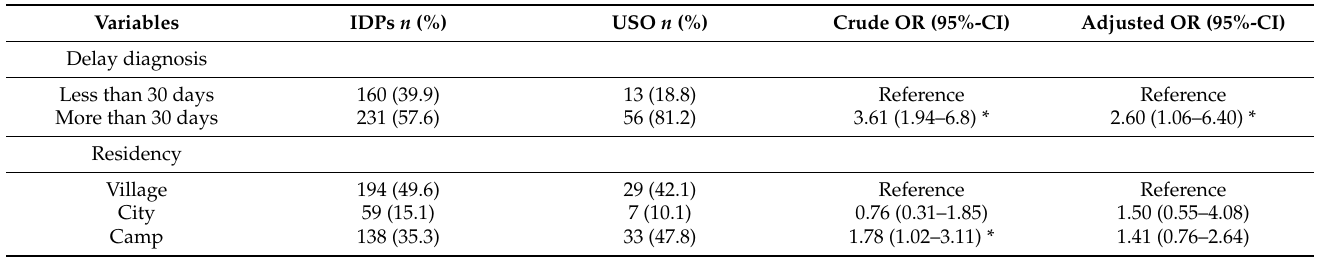
Table 4. Predictors associated with treatment outcomes in internally displaced TB